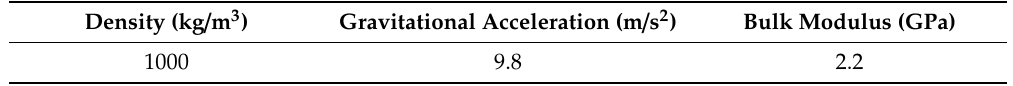
Table 2. Properties of the water.